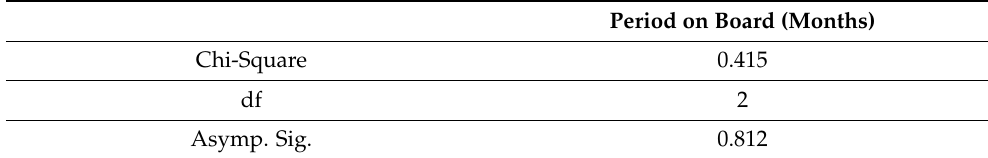
Table 13. Kruskal–Wallis test results for period on board.